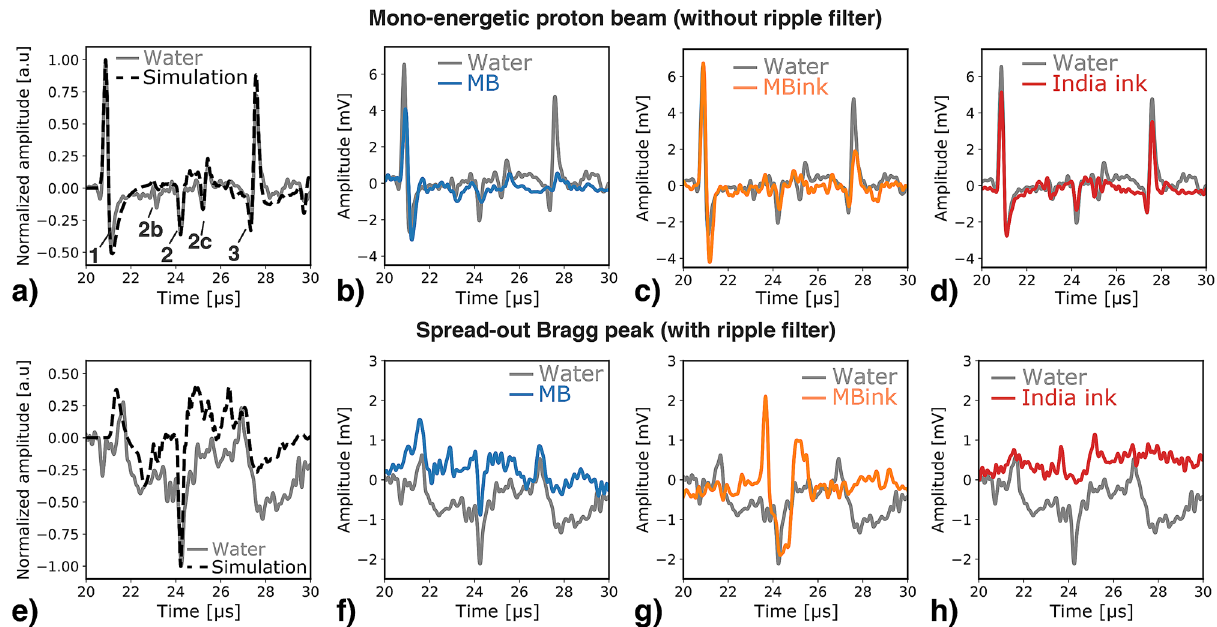
Figure 2. Ionoacoustic impulse response. Single-pulse ( 200ns ) measurements from mono-energetic 22 MeV proton beam, in water (gray) compared to ( a ) simulated signal (black dashed line), with ( b ) SonoVue microbubbles (blue), ( c ) SonoVue microbubbles in water/India ink mixture and ( d ) diluted India ink solution. The ionoacoustic signal is composed of a direct signal (1) arriving at t = 21 µ s (distance sensor to Bragg peak = 31 mm), pulse (2b) and its reflection (2c) from the CA phantom entrance and pulse (2) from the water tank entrance window at t = 24.3 µ s (distance sensor to entrance window ≃ 36mm ) and (3) the reflection of the direct signal (at t = 27.6 µ m corresponding to the 4.9 mm range of the proton beam). Ionoacoustic single-pulse (200 ns) measurements from the spread-out Bragg peak, in water (gray) compared to ( e ) simulated signal (black dashed line), with ( f ) microbubbles (blue), ( g ) microbubbles in water/India ink mixture and ( h ) diluted India ink solution. All the experimental measurements have been averaged over 3000 acquisitions and filtered using PyWavelets Python